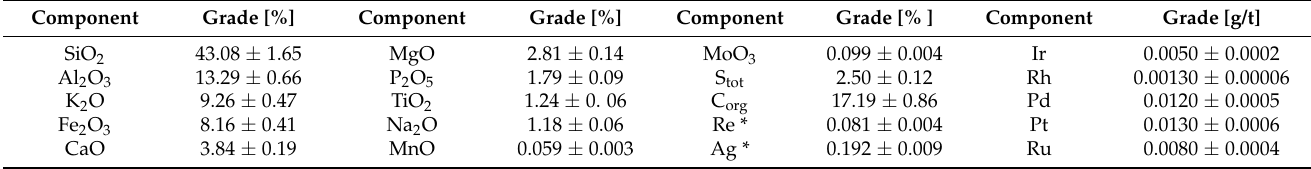
Table 3. Results of the investigation of the chemical composition of